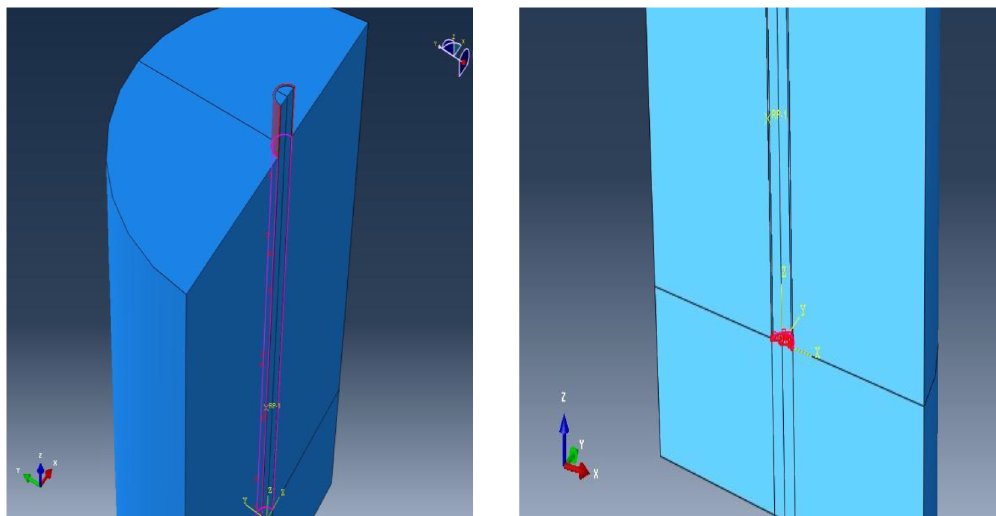
Figure 16. 3D construction of the model.